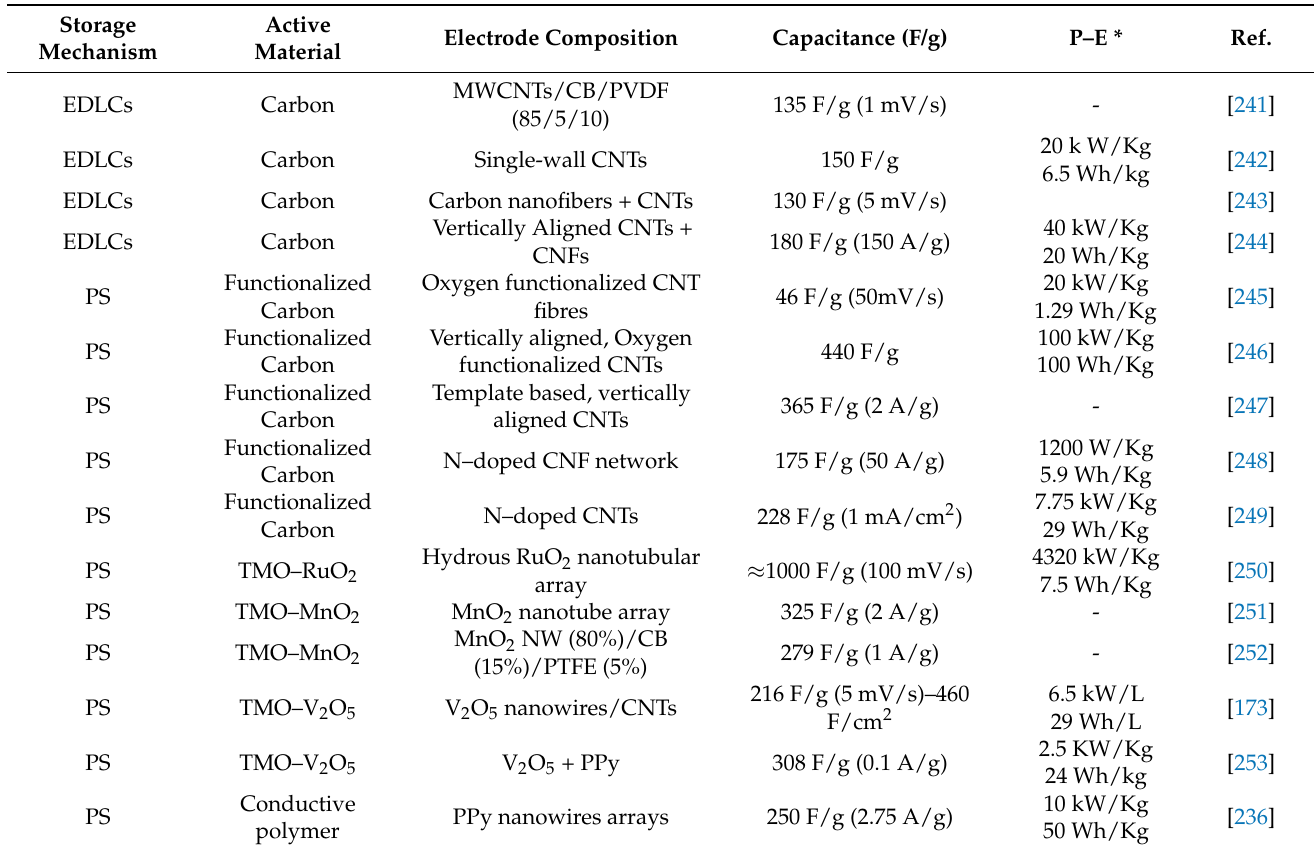
Table 2. Summary of supercapacitors performance for different active